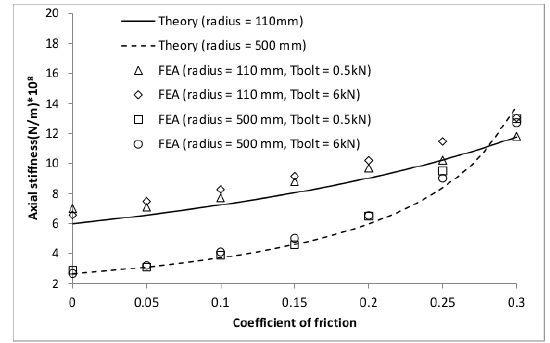
Figure 16: Axial stiffness for different coefficient of friction (theory and finite element model, T-bolt load =0.5 kN and 6